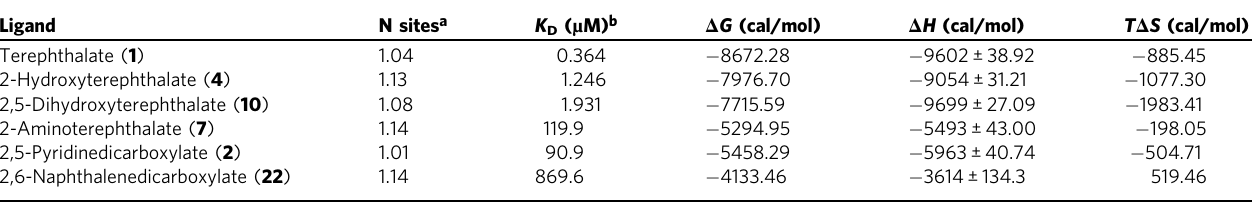
a N represents the stoichiometric ratio of protein:ligand interaction. b A higher af fi nity for terephthalate disodium and its 2-hydroxy- and 2,5-dihydroxy derivatives was